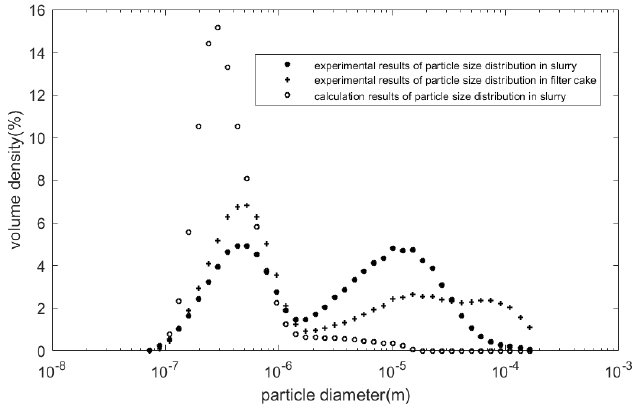
Figure 11. Size distribution of solid particles in the slurry and filter cake at 1200 s.